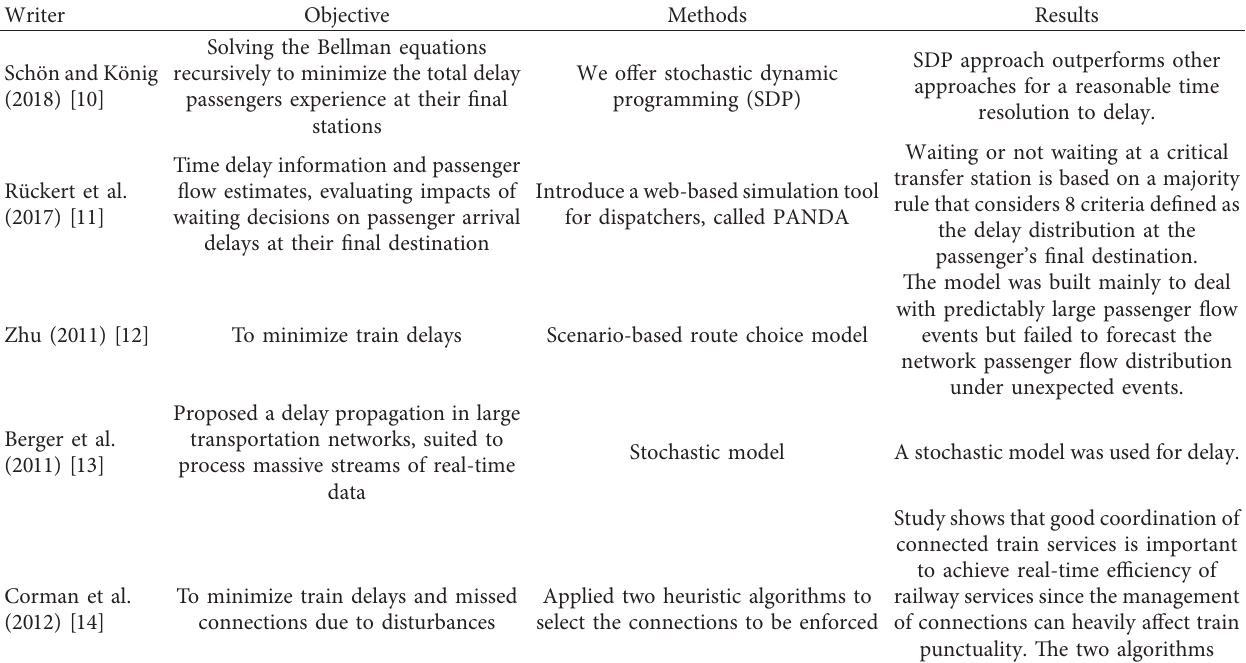
Table 1: Studies in the